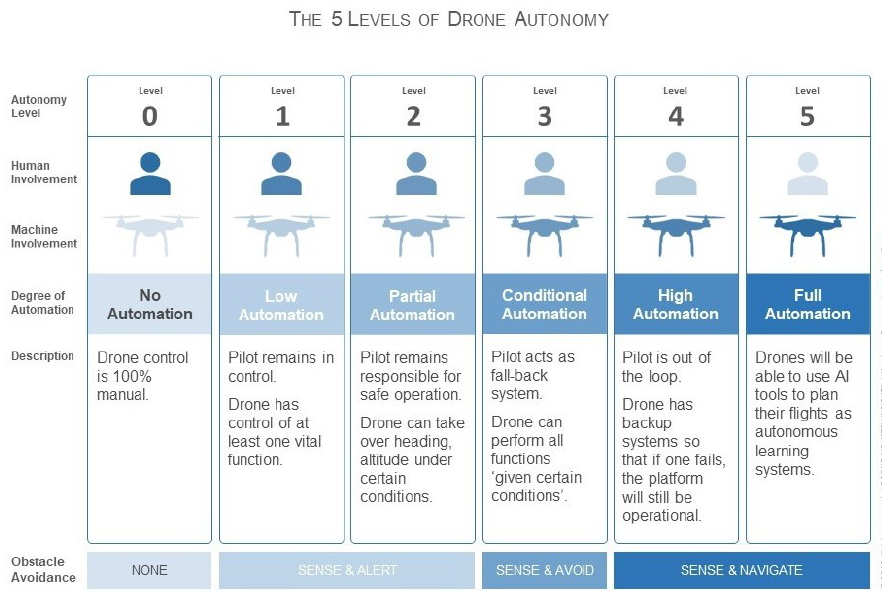
Figure 4. UAV regulations: a similar classification to the one defined by SAE for surface vehicles. Image credit: Drone Industry Insights .